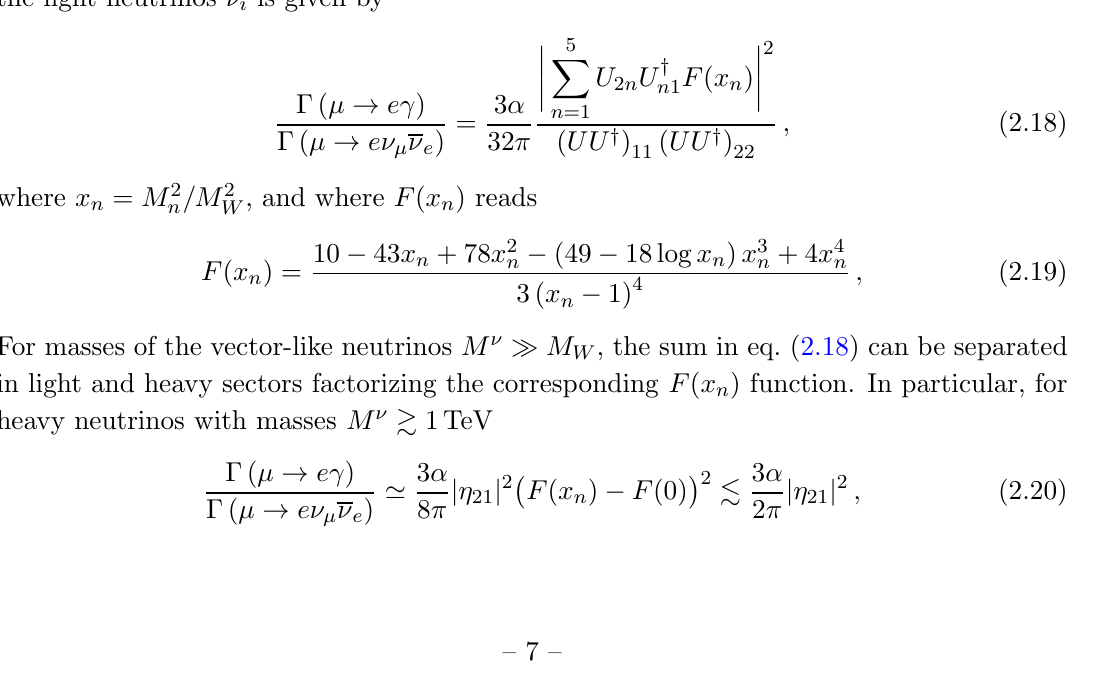
Figure 2 . Diagram showing the extra neutrino contributions to (cid:22) neutrinos in the mass basis, and (cid:30) (cid:0) represents the Goldstone boson. the Yukawa couplings are given